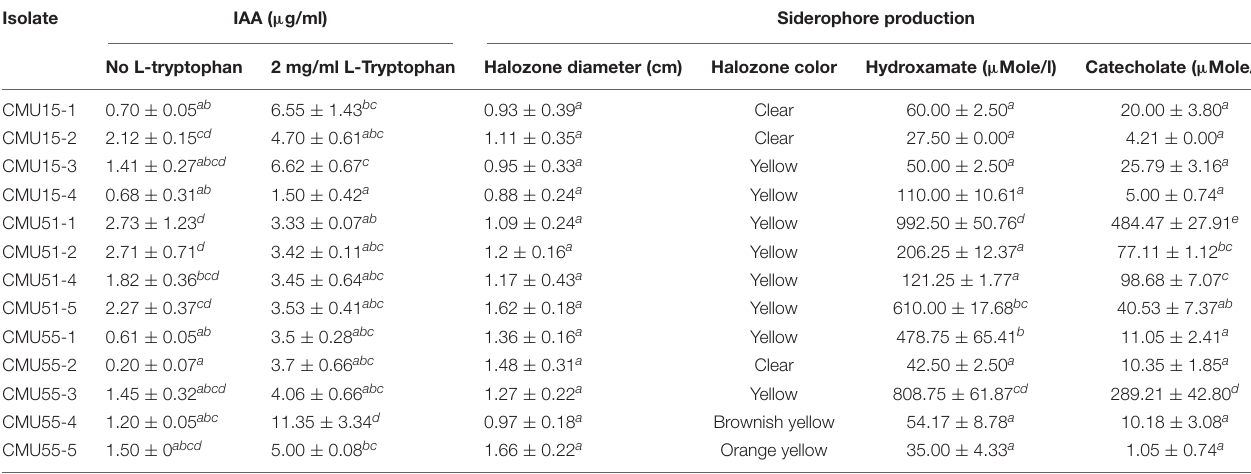
TABLE 1 | IAA and siderophore production.